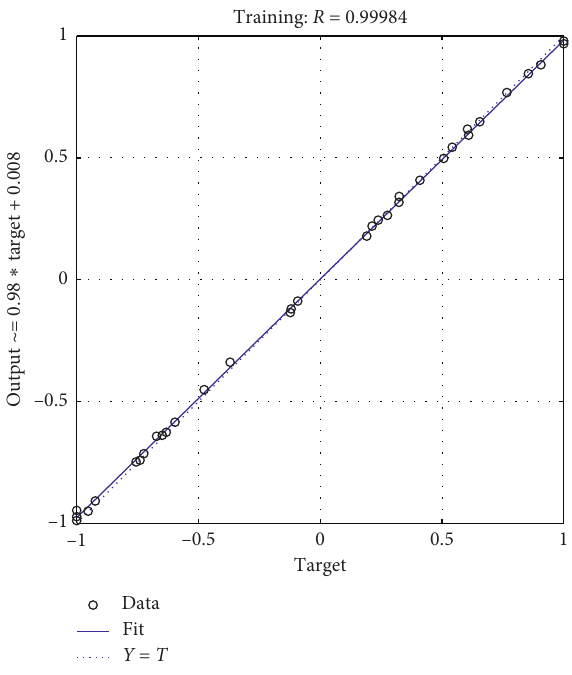
Figure 21: Training results.